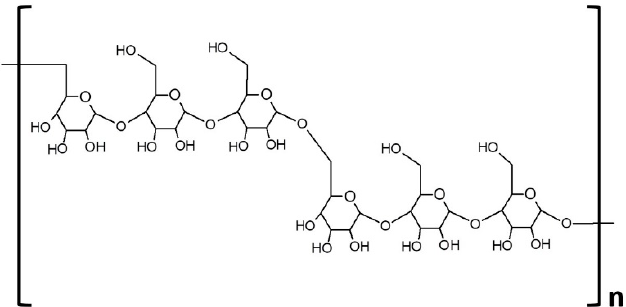
Figure 11. Representation of the pullulan chemical